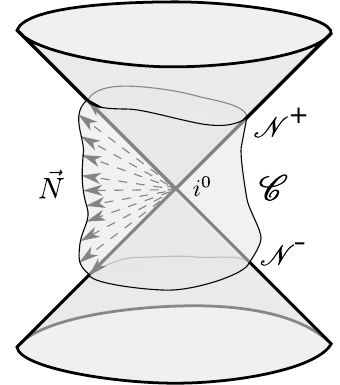
Figure 2 . The (cid:12)nite cylinder C in Ti 0 representing both null and spatial directions ~N at i 0 (drawn as dashed rays). The boundaries N (cid:6) (cid:24) = S 2 denote the space of null directions di(cid:11)eomorphic to the space of generators of I (cid:6) , respectively, while C n N (cid:6) is the space of rescaled spatial directions di(cid:11)eomorphic to the unit-hyperboloid H . The space C depends on the choice of the rescaling function (cid:6) (de(cid:12)ned below) and need not be a cylinder of unit radius in Ti 0 | we have drawn a \wiggly" cylinder to emphasise